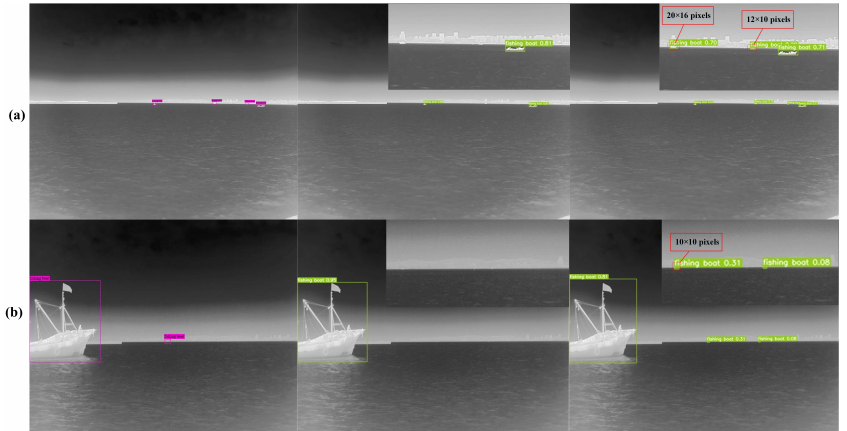
Figure 10. The detection results of small targets with different methods. GT represents the ground truth box, YOLOv5 represents the original baseline network model and YOLOv5+P2 represents the addition of high resolution feature layer P2 based on YOLOv5; ( a , b ) represent the 2 groups of detection results, respectively.